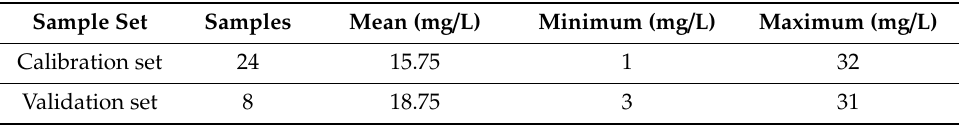
Table 1. Statistical results of COD value by